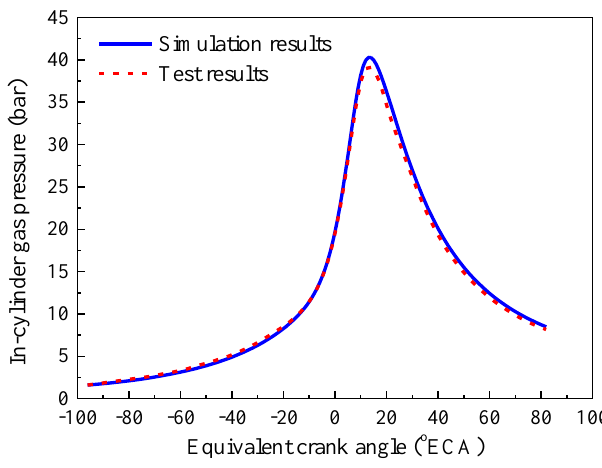
Figure 11. Comparison of the simulated and tested in-cylinder gas pressure.